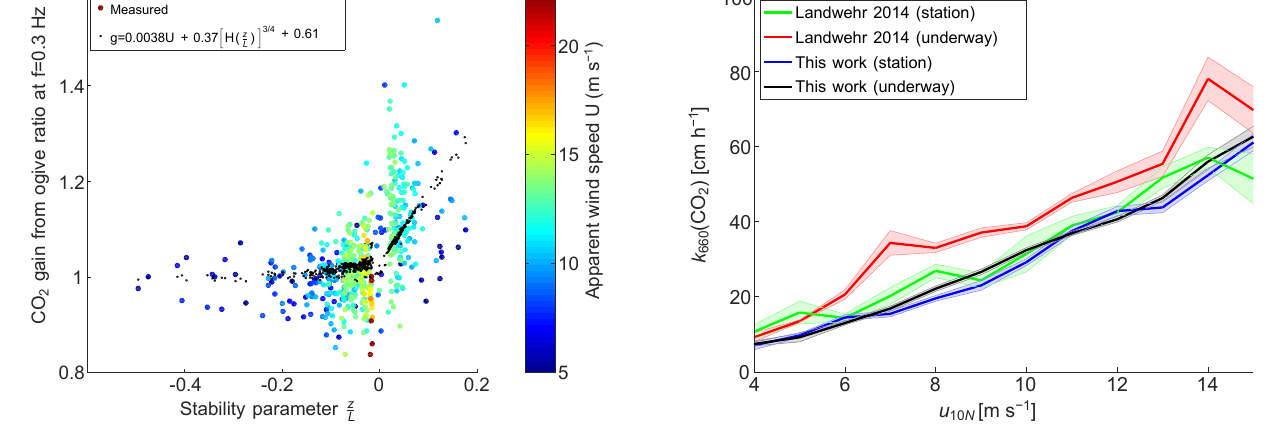
Figure 3. Estimated CO 2 transfer velocities separated into “station” Figure 2. CO 2 gain factor ( g CO ) as a function of apparent wind 2 (u ship < 1ms − 1 ) and “underway” (u ship ≥ 1ms − 1 ) , and bin aver- speed U (colour) and stability parameter z . The result of a simple L aged over 1ms − 1 wind-speed bins. Shown are the estimates from ) (cid:3) 3 / 4 + C g ) is shown regression analysis (g = A g · U + B g · (cid:2) H( z L Landwehr et al. (2014), where the double rotation of the wind vec- as black dots. tor was performed after it had been corrected for mean- and wave- motion-induced ship motion (green and red), and from this work, where the radial planar fit method has been employed to estimate the vertical tilt of the wind vector (Landwehr et al., 2015). The shaded areas mark 1 standard deviation from the bin average. The plot has been restricted to the wind-speed range 4–15ms − 1 where sufficient on-station and underway measurements were both